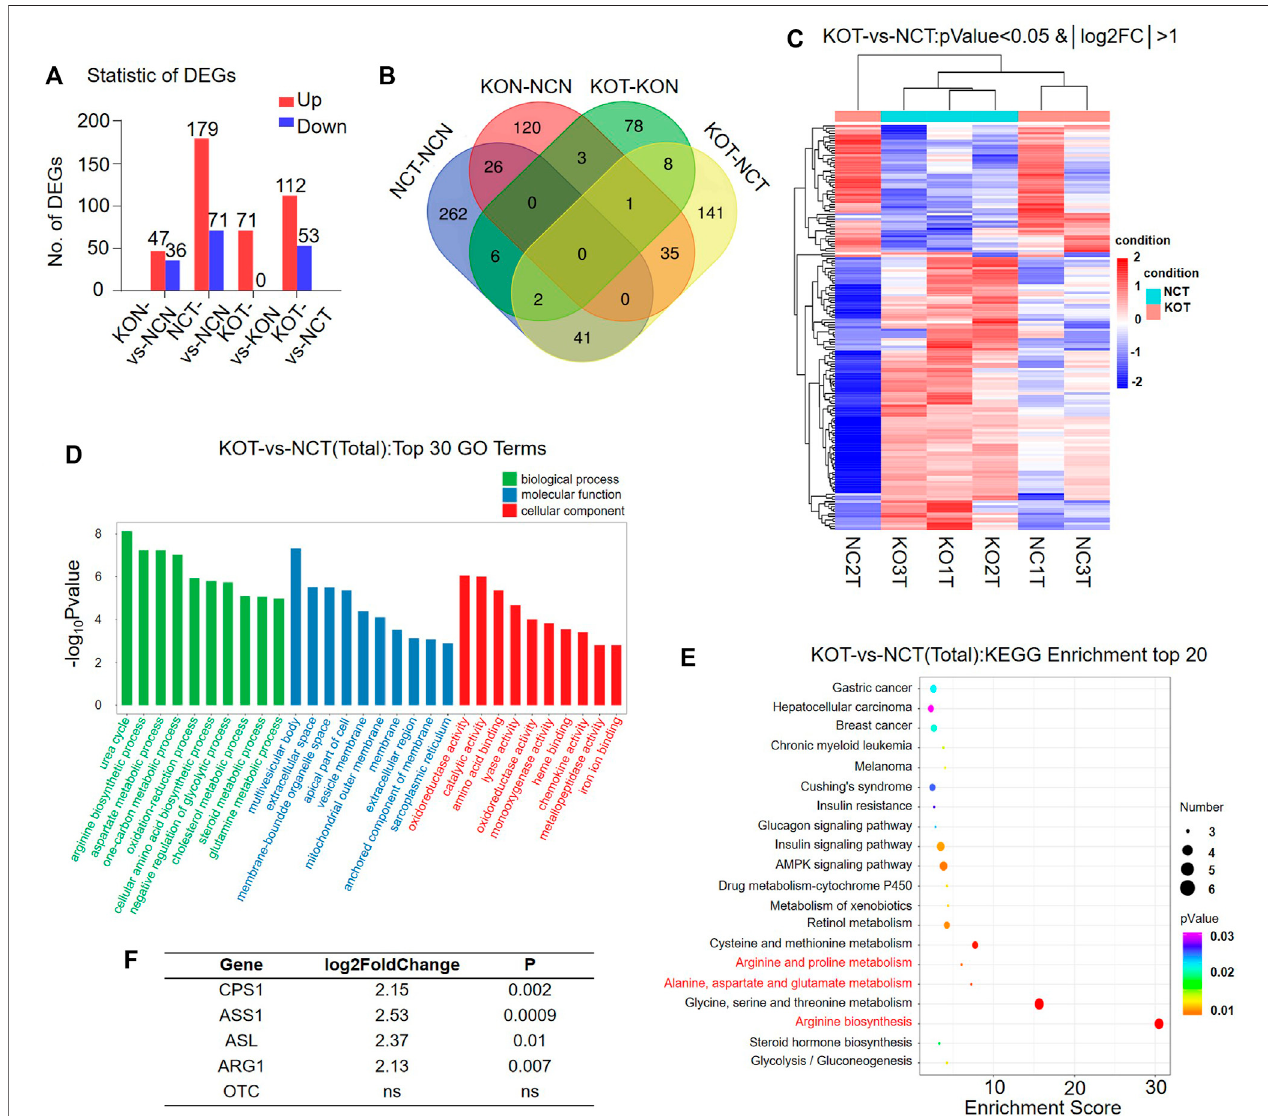
FIGURE3| UreacycleisremarkablyactivatedinN fi b − / − livertumors. (A) Thenumberofdifferentiallyexpressedgenes(DEGs)inmiceinapair-wisecomparison. (B) Venn diagram showed the overlaping of DEGs in different groups. (C) Heatmap diagrams showed the relative expression levels of total DEGs among the KOT vs. NCT group. The upregulated genes are in read, and the downregulated genes are in green. (D) GO analysis of DEGs between KOT and NCT in three main categories. (E) KEGG pathway enrichment analysis of the annotated DEGs. (F) The foldchange of urea cycle enzymes between KOT and NCT tumors.